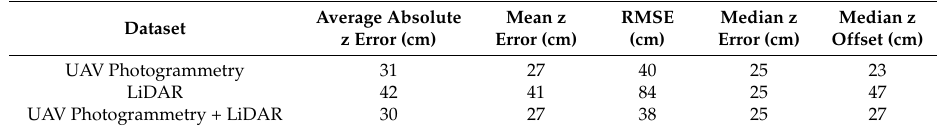
Table 1. Dataset Accuracies: Comparison of Dataset Elevations against all RTK Surveyed Point Elevations (678 UAV Photogrammetry dataset and 629 LiDAR and UAV photogrammetry + LiDAR datasets).